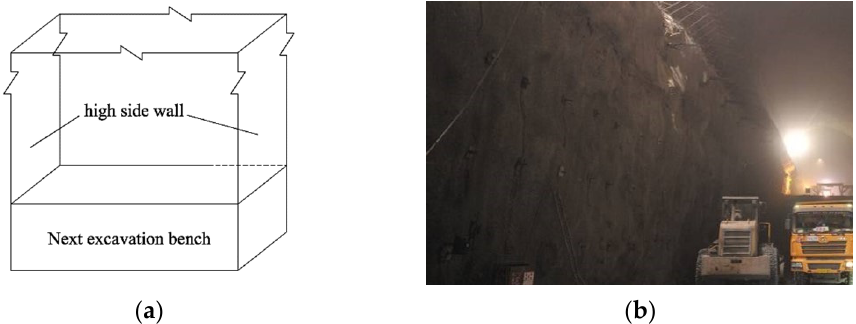
Figure 16. High side wall zone of underground powerhouse. ( a ) The excavation diagram of the high side wall zone. ( b ) The engineering scene of the high side wall zone.